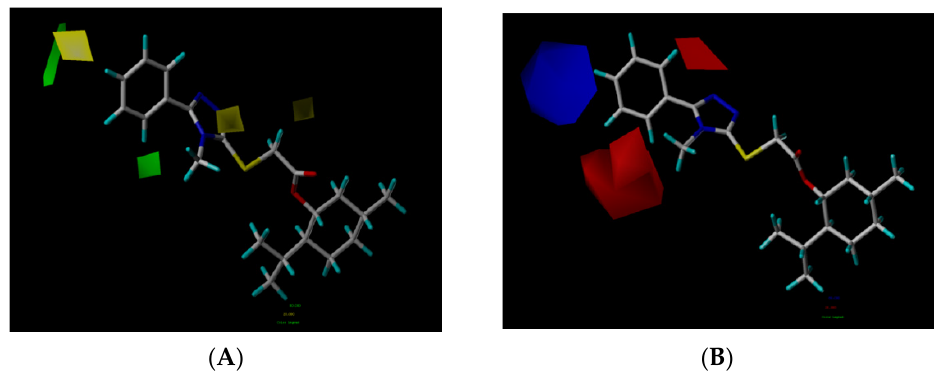
Figure 2. Contours of CoMFA analysis: ( A ) contours of steric contribution are represented in yellow and green; ( B ) contours of electrostatic contribution are represented in red and blue.